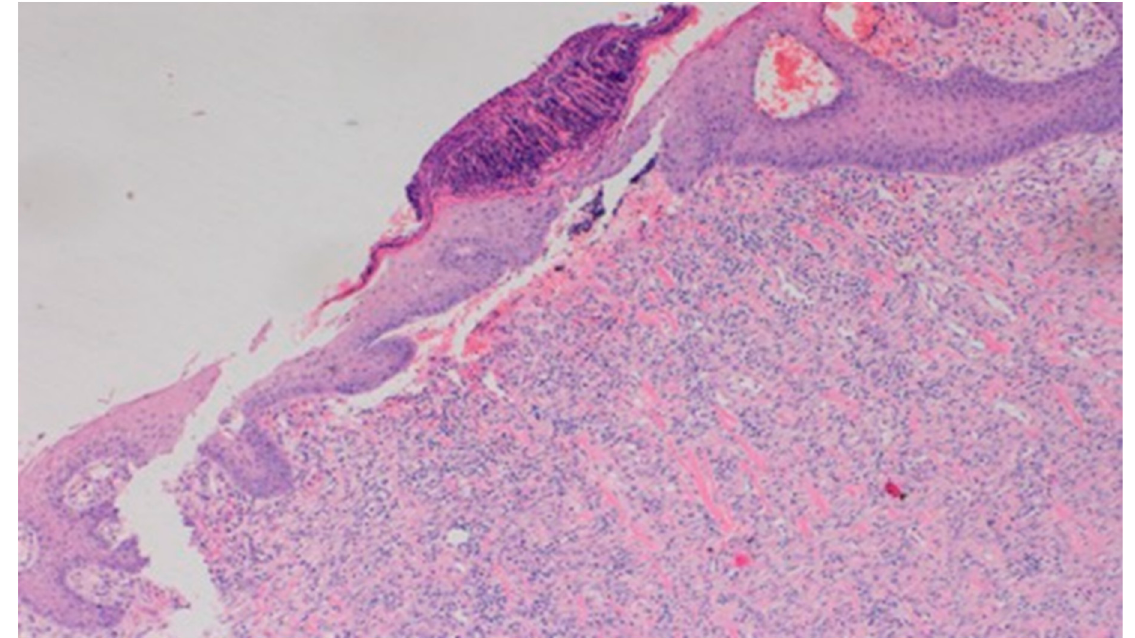
Figure 21. Focal, detachable necrosis on the epidermal skin lesion. Under the epithelium, a low-density lymphocytic inflammatory infiltration (40 × , H-E) in the wound treated with the 1% propolis ointment on day 20 is visible.